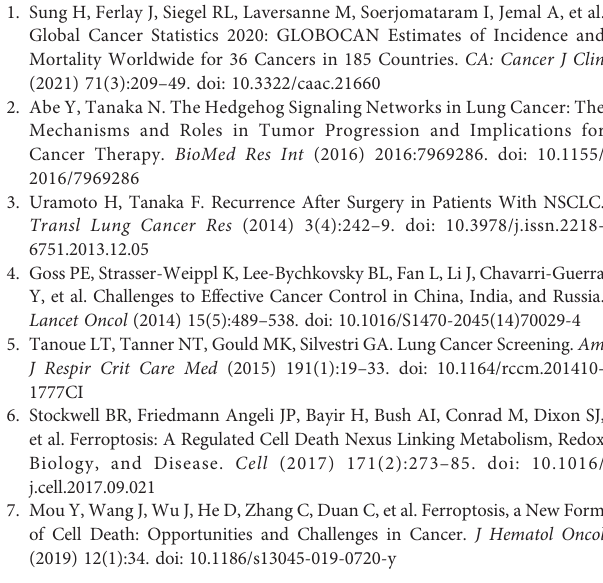
Supplementary Figure 8 | Validation of FRGscore in different molecular subgroups in GSE31210 cohort. (A, B) Proportion of patients harboring EGFR